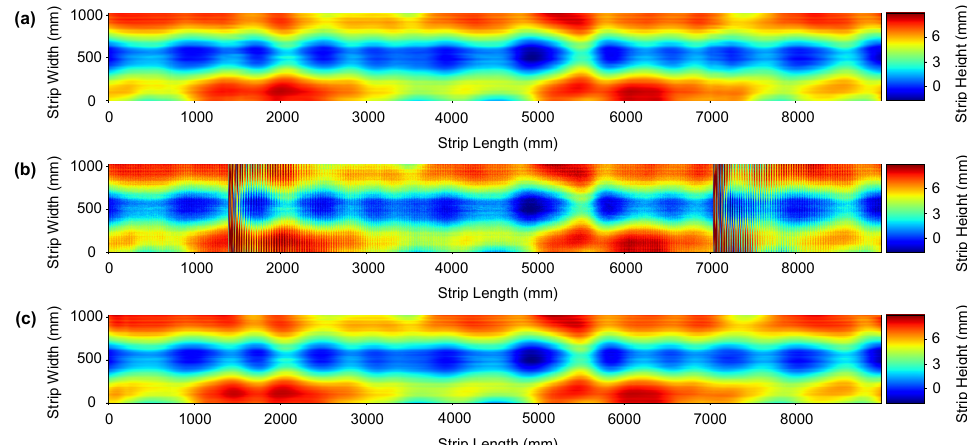
Figure 12. An instance of a real metal sheet surface denoising. Plate thickness: 3 mm; yield point Re: 215 MPa; Dimension of the mother plate—length: 9 m; width: 1050 mm. ( a ) Hermite filter denoised ground truth surface, ( b ) noise corrupted surface and ( c ) denoised reconstructed surface using the proposed network. (Color online).